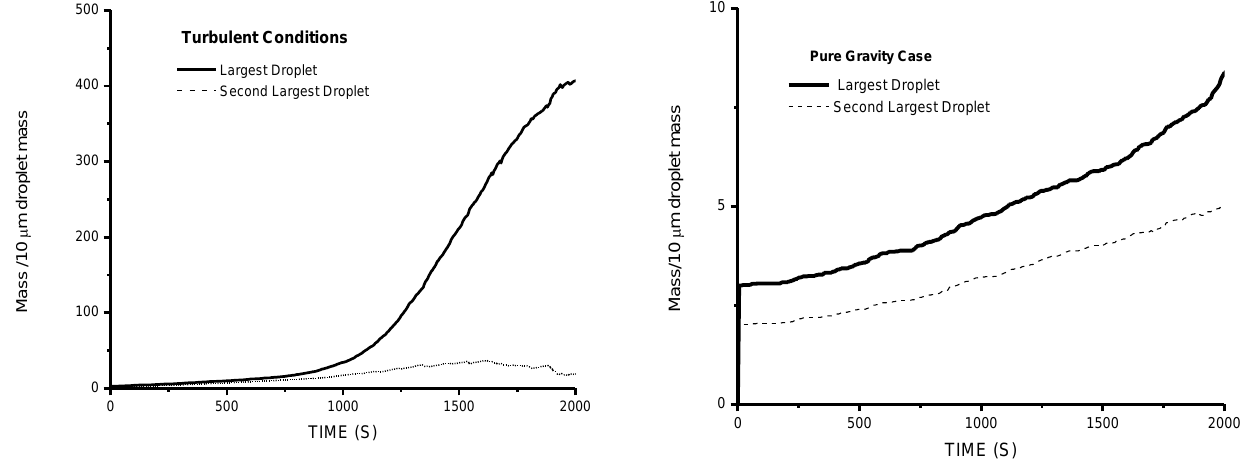
Fig. 7. Same as Fig. 4 but for the pure gravity case.